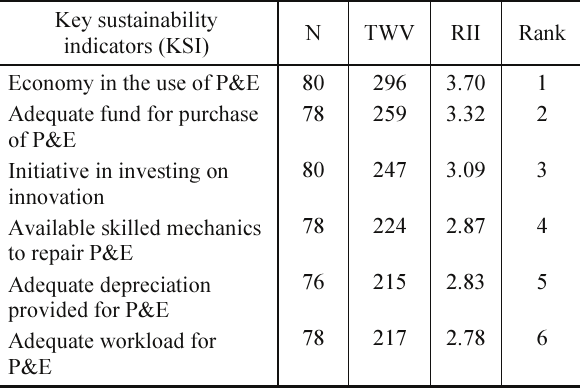
Table 6. Level of sustainability of excavation operation